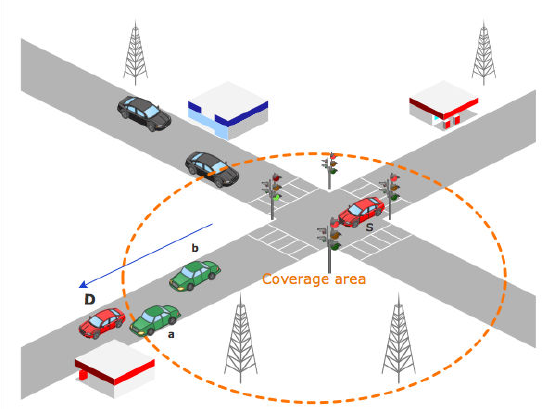
Figure 5. In this scenario node, s should select neighbor a as next hop, but even if that is not the closest to destination D , b ensures a better link lifetime than a .